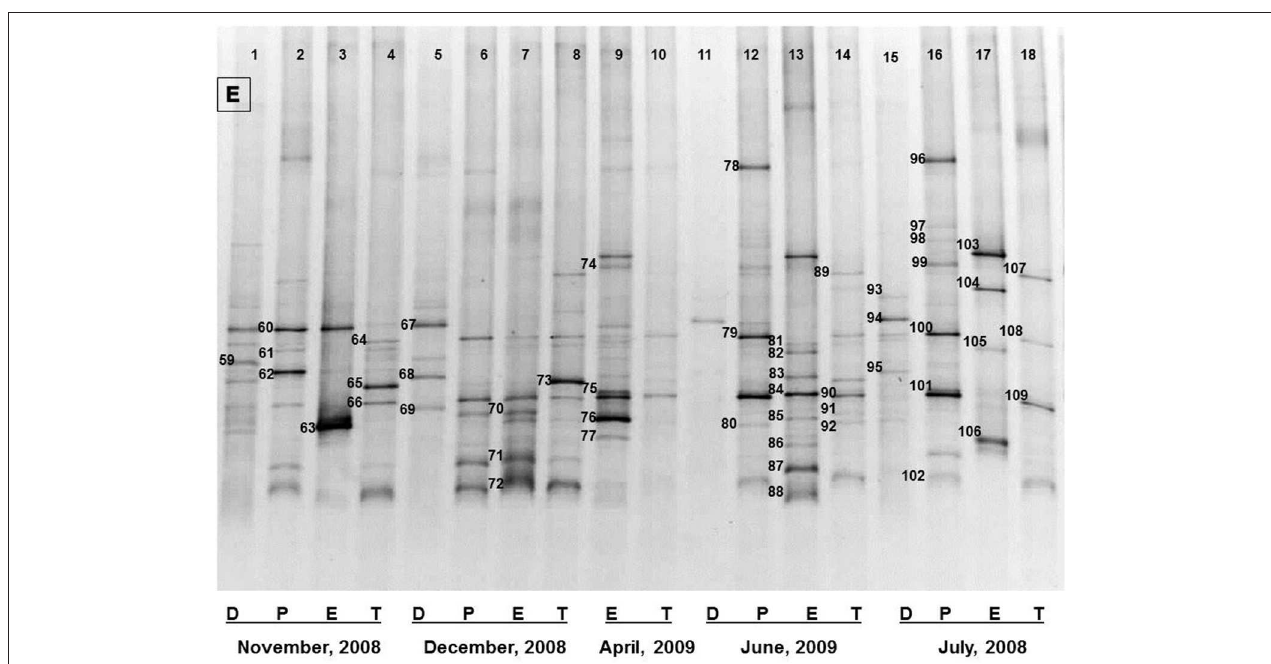
FIGURE 3 | The representative DGGE profiles of bacterial community of Dhanmondi Lake site I in July 2008–June 2009. D, P, E, and T stand for the Direct, Pre-enriched, Enriched, and Total heterotrophic DNA